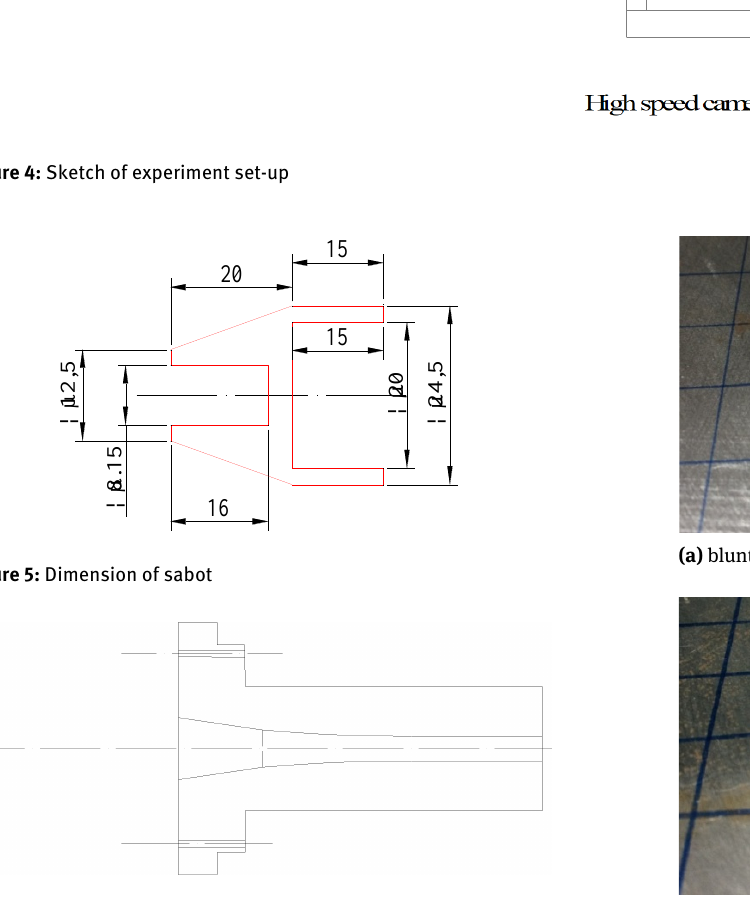
Figure 6: Projectile sabot removal device